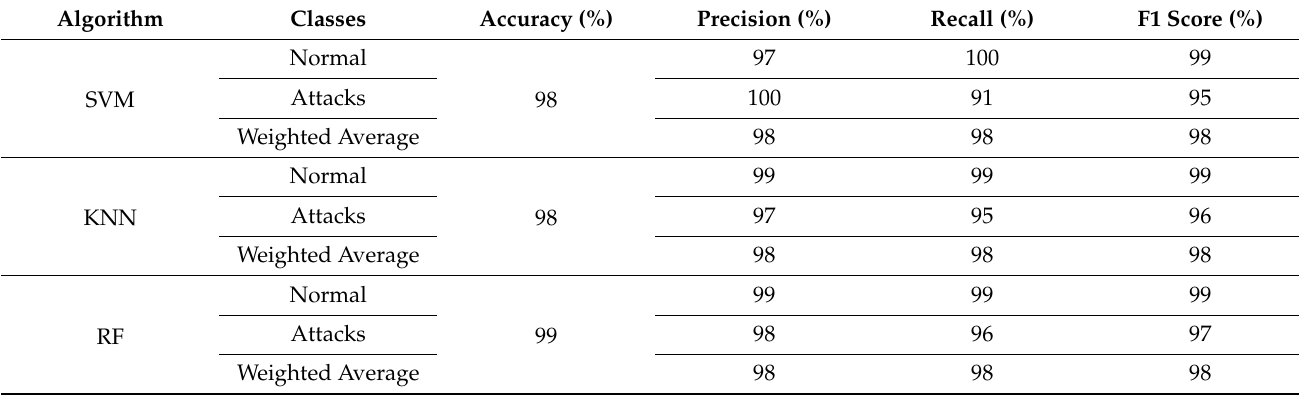
Table 4. Results of machine learning for binary